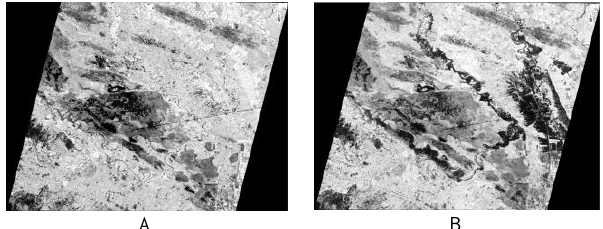
Figure 5. Final flood maps; A) without morphology, B) with morphology.